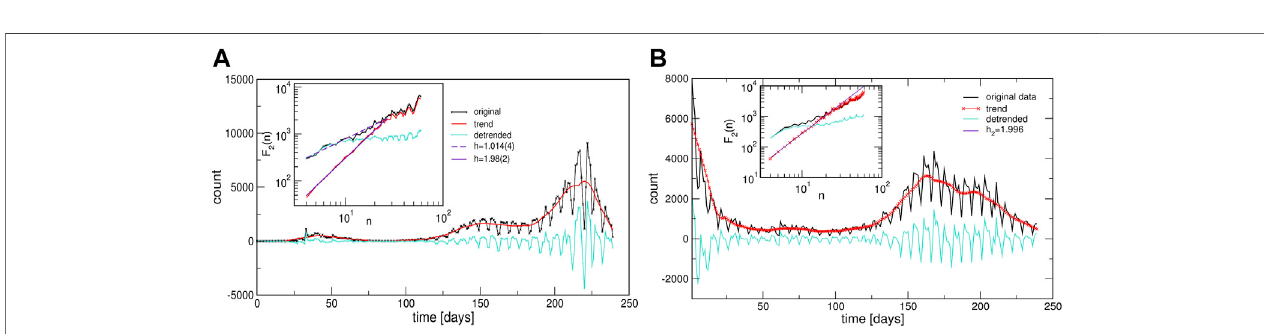
FIGURE 7 | Two examples of the infection time series showing cyclic trends during the outbreak phase [from Israel, (A) ], and during the immunisation phase [from Portugal, (B) ]. Insets show the corresponding functions of the standard deviation fl uctuations for the identi fi ed trends and the original and detrended time series.